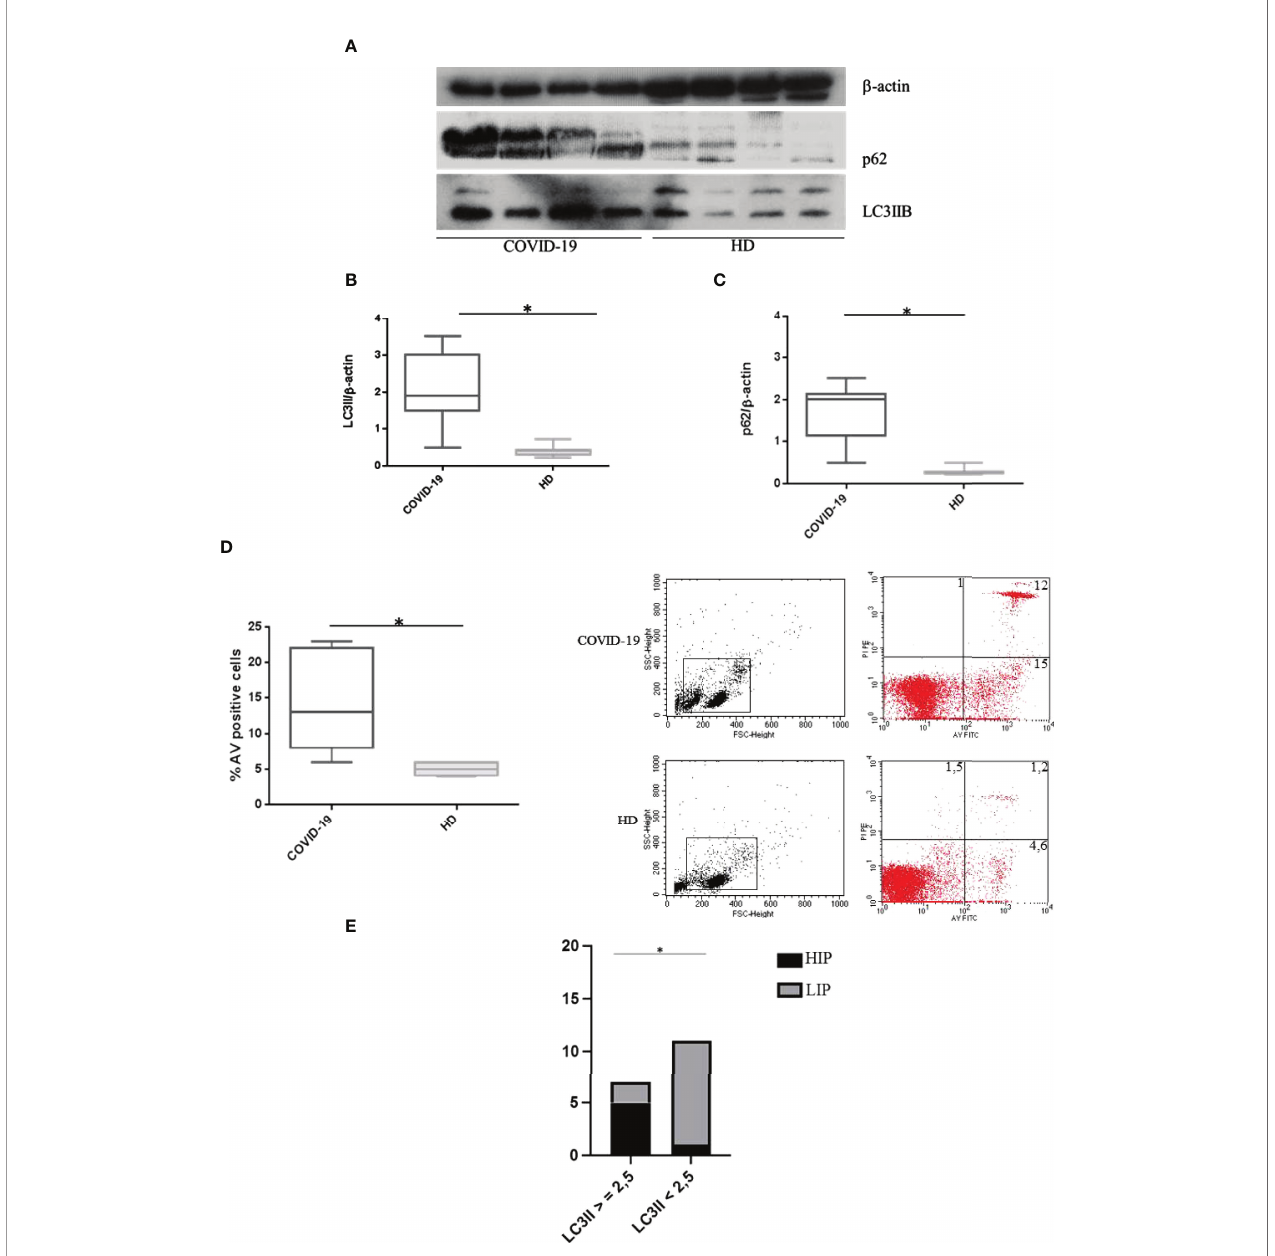
FIGURE 1 | Spontaneous autophagy and apoptosis in COVID-19 patients and HDs. (A) LC3IIB and p62 Western blotting analysis of PBMC lysates (30 m g/lane) from 4 COVID-19 patients and 4 HDs. Blots shown are representative of independent experiments performed on COVID-19 patients ( n = 18) and HDs ( n = 12). Quanti fi cation of LC3IIB (B) and p62 (C) levels relative to b -actin is also shown (mean with range is presented) (Mann – Whitney test). (D) Flow cytometry analysis of PBMC apoptosis. Data are referred to as AV-positive cells and are presented as independent experiments performed in PBMC from COVID-19 patients ( n = 18) and HDs ( n = 12) (Mann – Whitney test). (E) Contingency: prospective data (chi-square test) between LC3IIB level and HIP/LIP patients. Values are expressed as means ± SD. * p < 0.05. COVID-19, coronavirus disease 2019; HDs, healthy donors; PBMC, peripheral blood mononuclear cell; AV, annexin V; HIP, high in fl ammatory pro fi le; LIP, low in fl ammatory pro fi